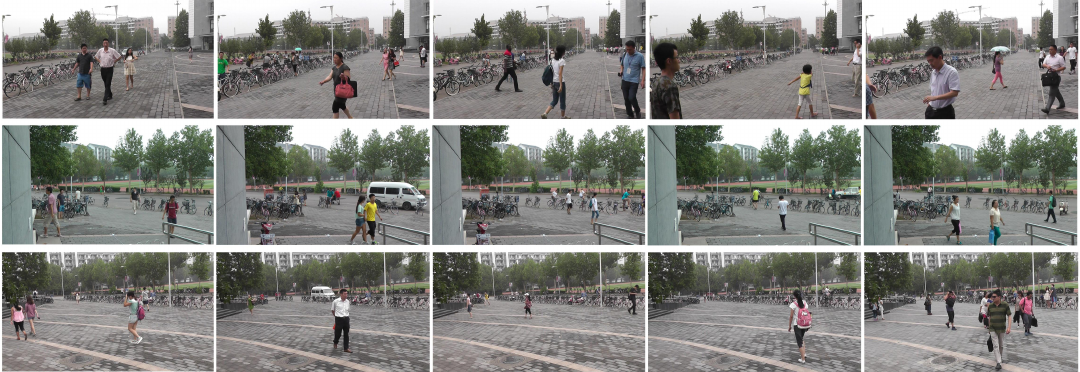
Figure 9. Examples extracted from PRW-v16.04.20 Database [19]. There are three different cameras that are capturing frames with several persons. The conditions are incredibly different when compared to RPIField